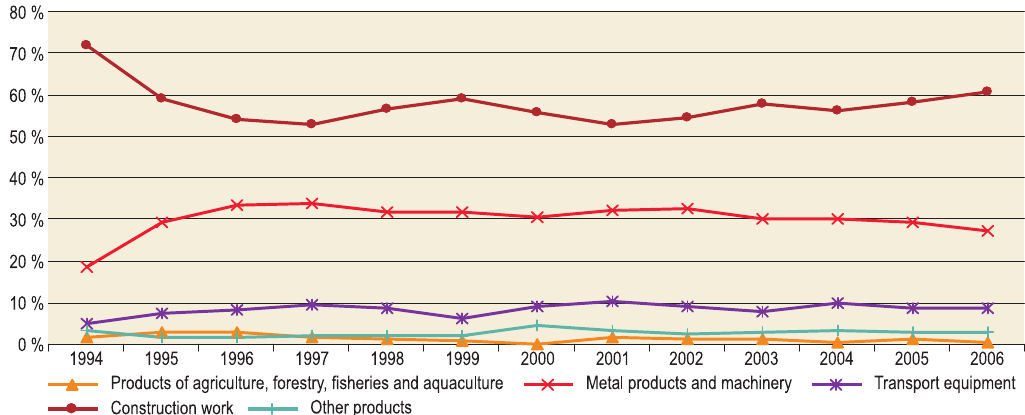
Fig. 4. Structure of fi xed investments by 5 asset types in